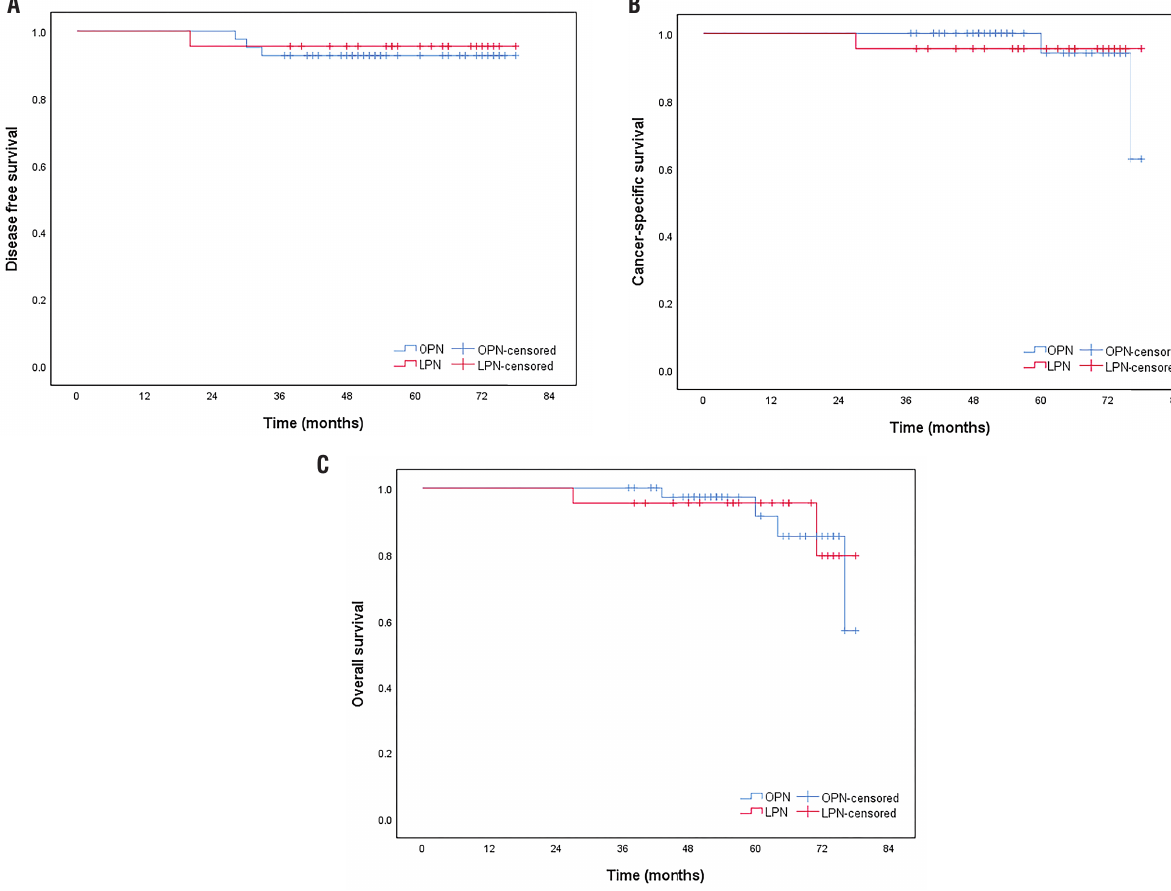
Figure 1 - Disease-free survival (a), cancer-specifi c survival (b), overall survival (c) according to the surgical